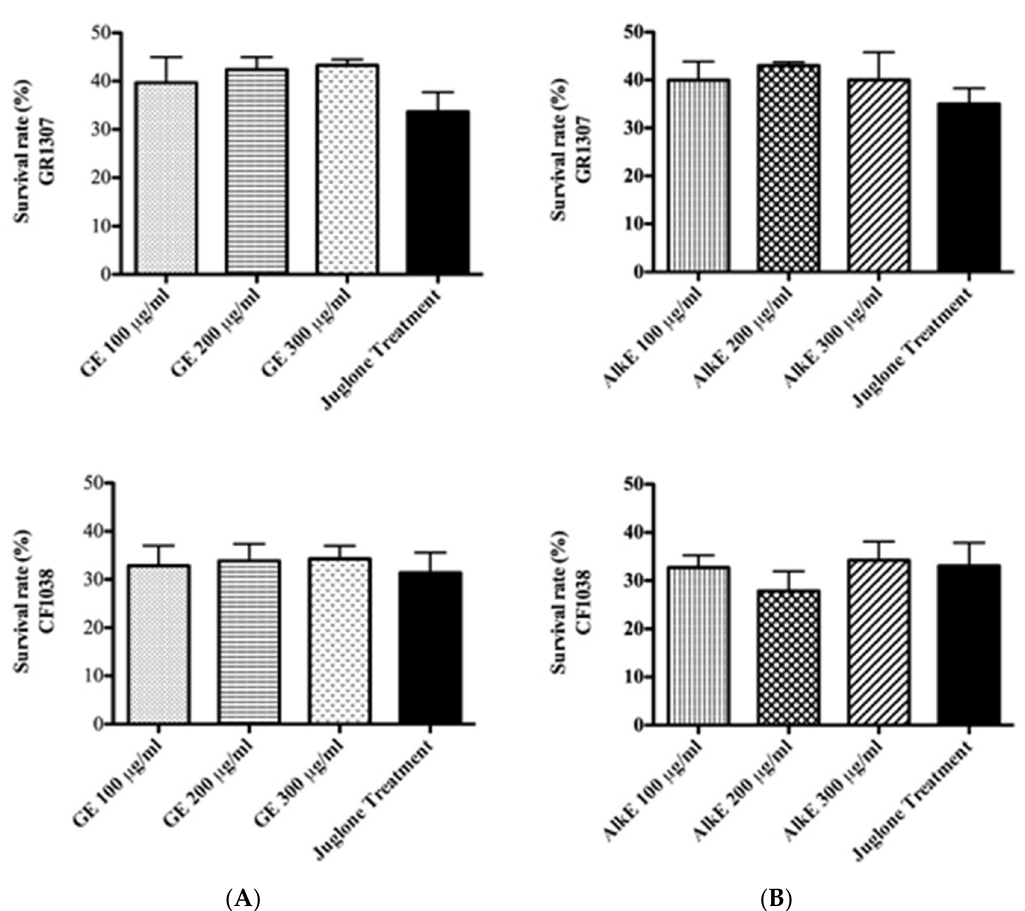
Figure 2. Effect of GE ( A ) or AlkE ( B ) treatment on the survival rate of the mutant strains CF1038 and GR1307 under juglone-induced oxidative stress. The DAF-16 mutant worms (GR1307 [daf-16(mgDf50) I] and CF1038 [daf-16(mu86) I]) did not respond to GE or AlkE treatment. Each bar represents the mean ± SEM from three independent experiments. The treatment groups are compared with the untreated control by one ‐ way ANOVA followed by Bonferroni’s method (post ‐ hoc).